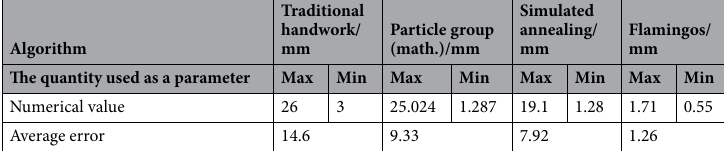
Table 6. Average error comparison table.